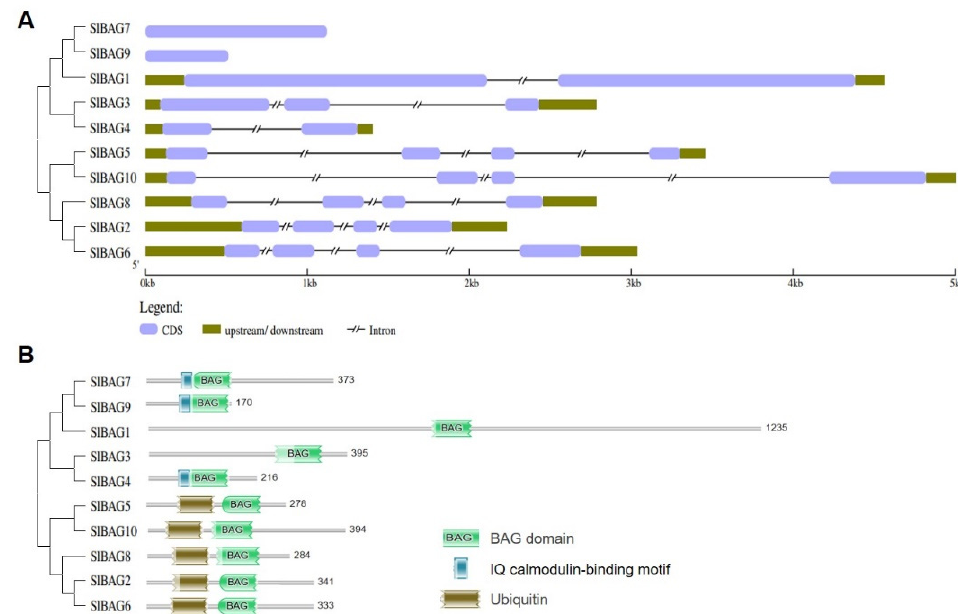
Figure 3. Gene structure and BAG domain of SlBAG family in tomato. ( A ) The gene structure was generated using a Gene Structure Display Server (GSDS version 2.0). The length of exons as well as introns and UTRs of each SlBAG gene are displayed proportionally. ( B ) BAG domains were generated through the HMMER web server (Biosequence analysis using profile hidden Markov Models|HMMER). The legends of BAG domain, Ubiquitin-like domain and IQ calmodulin-binding motif are listed on the right. The phylogenetic tree was constructed referring to Figure 2. SlBAG proteins are listed on the left.